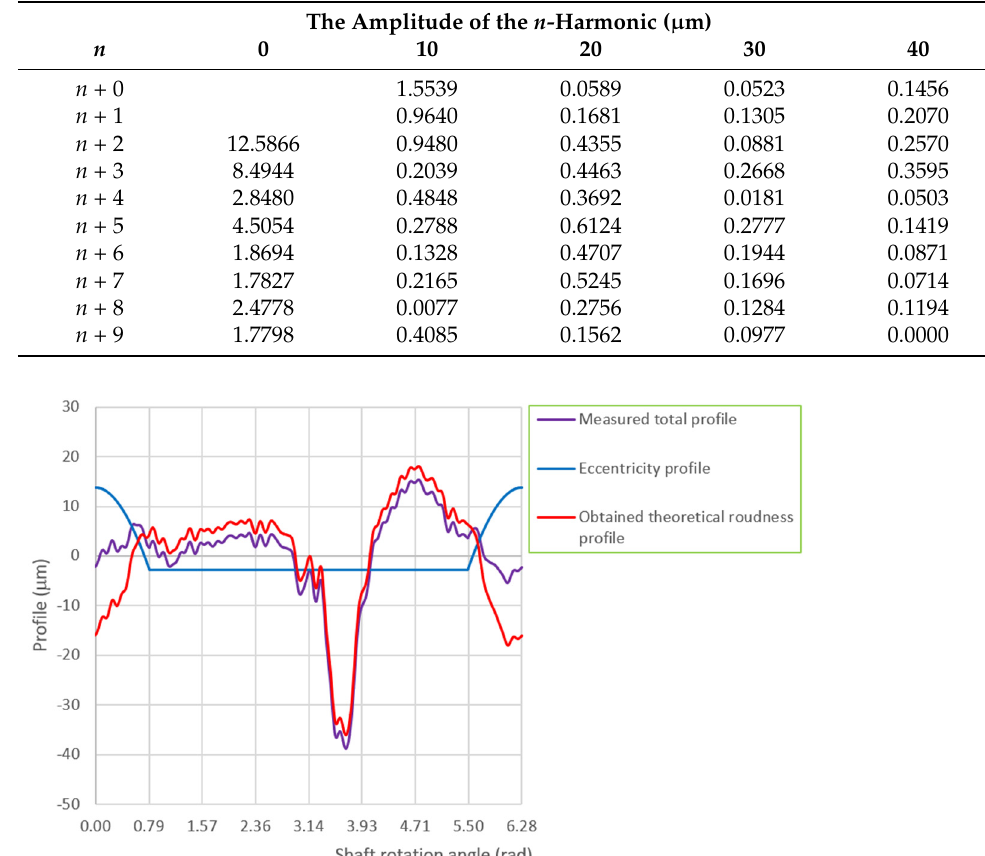
Figure 14. Theoretical roundness profile of the journal No. 4 ( a ), and discrete amplitude spectrum ( b ). Table 4. Values of the amplitudes of the harmonic components of the theoretical roundness profile of journal No. 4.